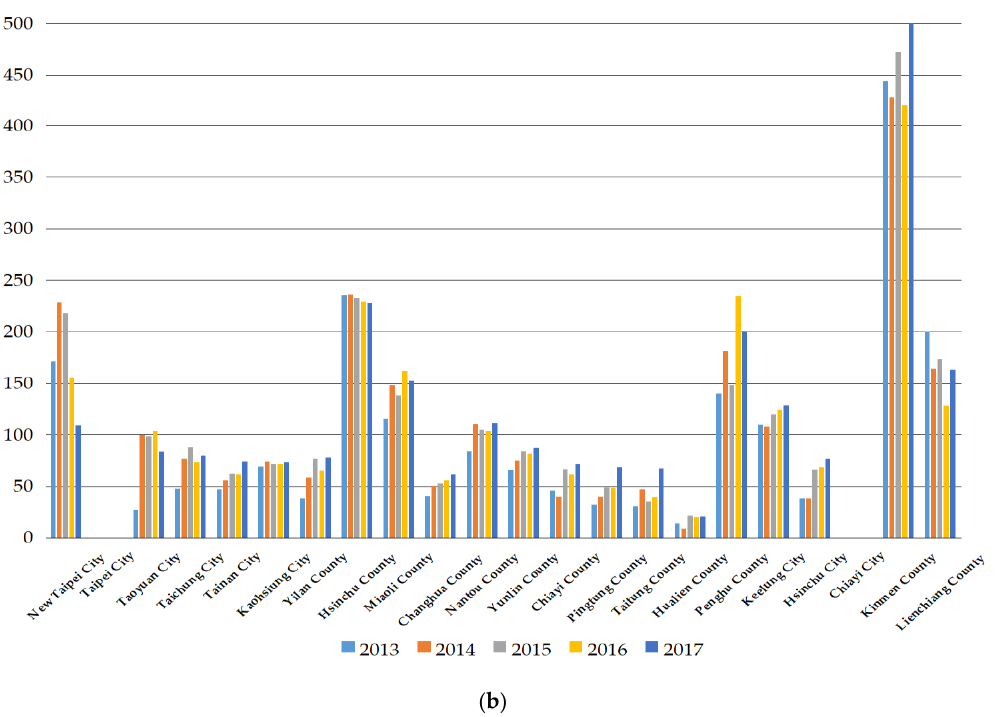
Figure 4. ( a ) The potential adjustment ratio of physicians for each administrative region in Taiwan; ( b ) The potential adjustment ratio of nurses for each administrative region in Taiwan.